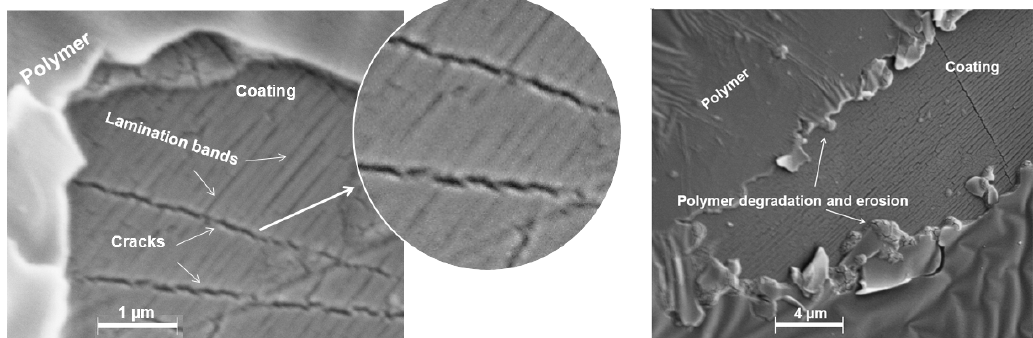
Figure 4. PET surface exhibiting persistent adherence of salmon muscle in food cans stored for 12 months; damage morphology of the different layers in the food can.